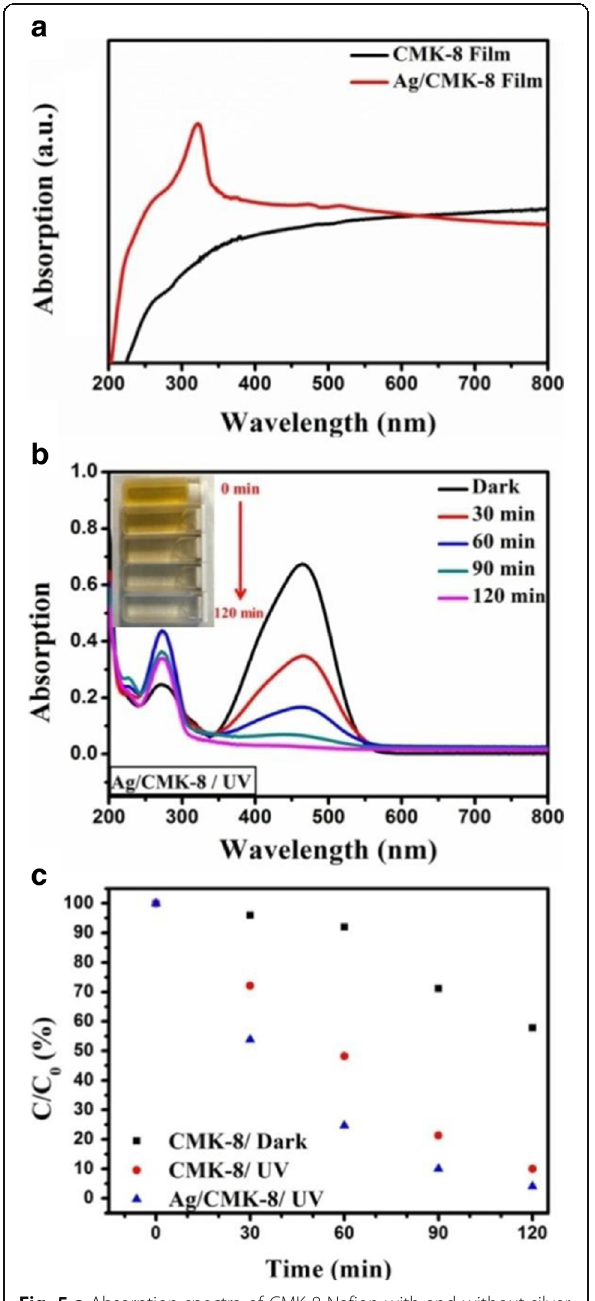
Fig. 5 a Absorption spectra of CMK-8-Nafion with and without silver NPs. b UV-Vis spectrum evolution of MO decomposition with the Ag/CMK-8-Nafion membrane. c A comparison of MO decomposition efficiency levels with different experimental